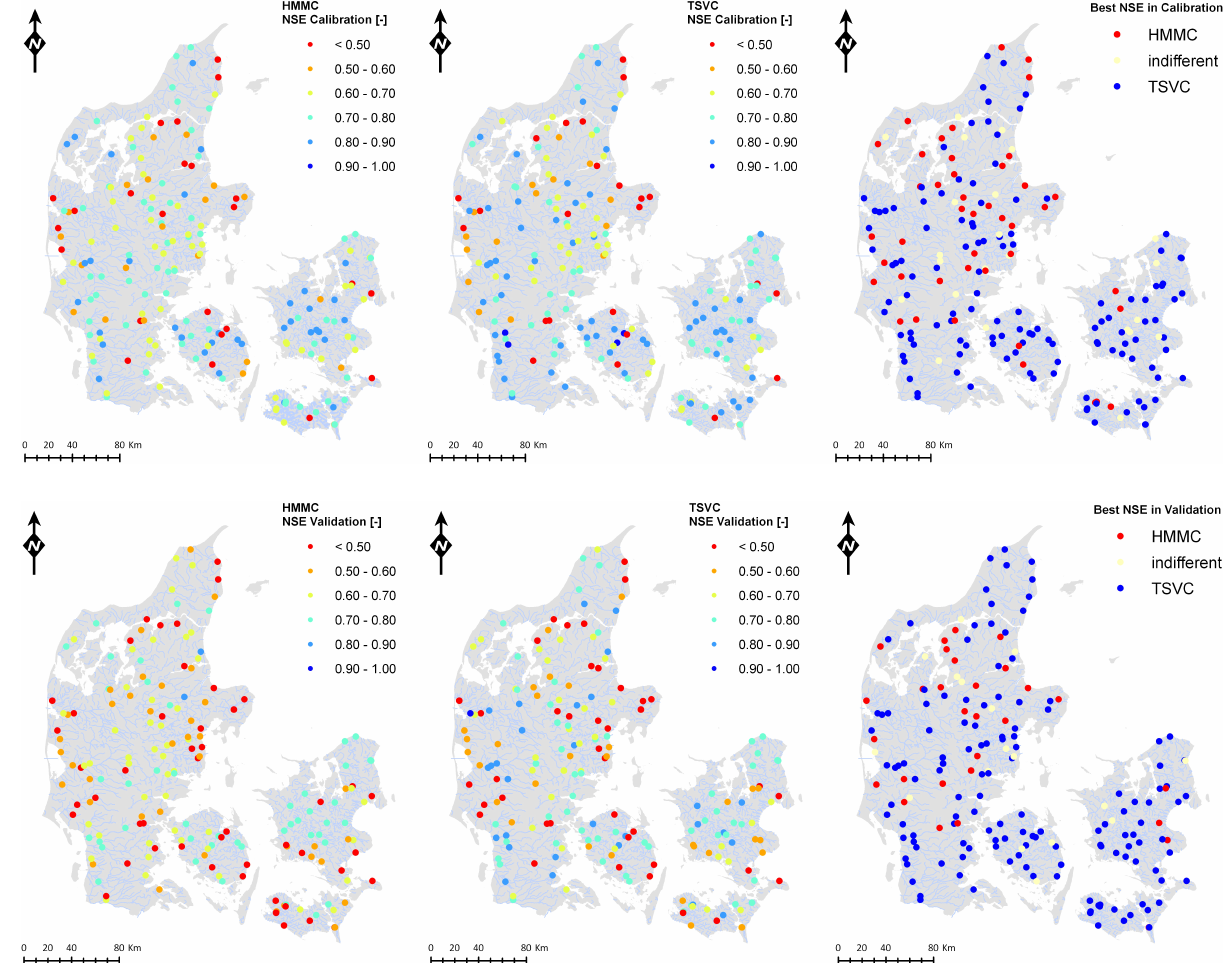
Fig. 9. Distributed map of model performance for NSE for both models during calibration and validation.